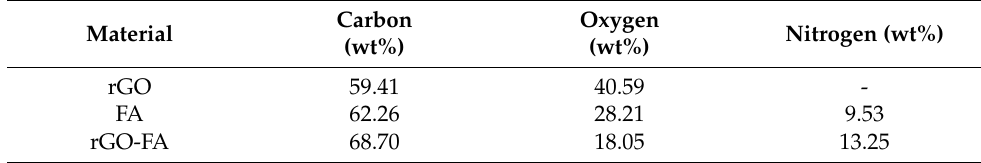
Table 1. EDAX analysis results of